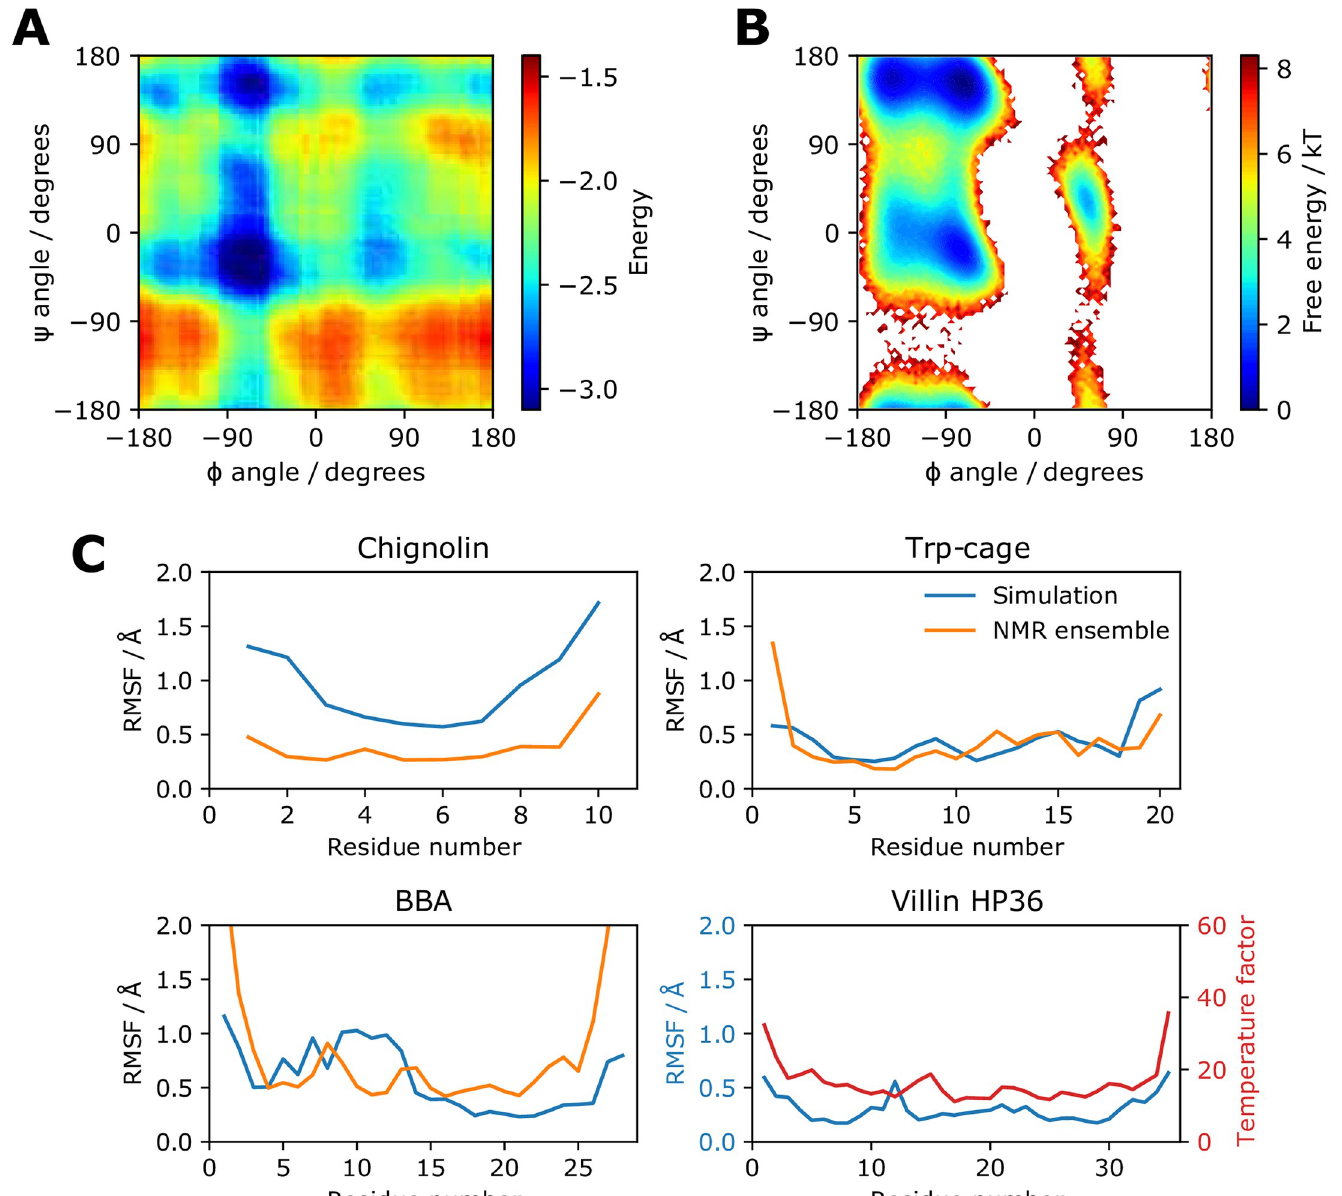
Fig 3. Protein energy and dynamics. (A) The energy of alanine dipeptide in the learned potential for different φ and ψ torsion angles. Conformations are generated with PeptideBuilder at intervals of 2˚ and scored. (B) Free energy for different φ and ψ torsion angles for all-atom alanine dipeptide. The energy is obtained from direct histogram estimation from all-atom simulations. The data is taken from Wang et al. 2019 [15] and provided by the authors. (C) C α atom RMSF values for simulations of 6m steps using the learned potential starting from the native structure. An initial burn-in period of 6m steps was discarded. The C α atom RMSF values from the NMR ensembles are also shown, or the C α atom crystal temperature factors in the case of villin HP36.